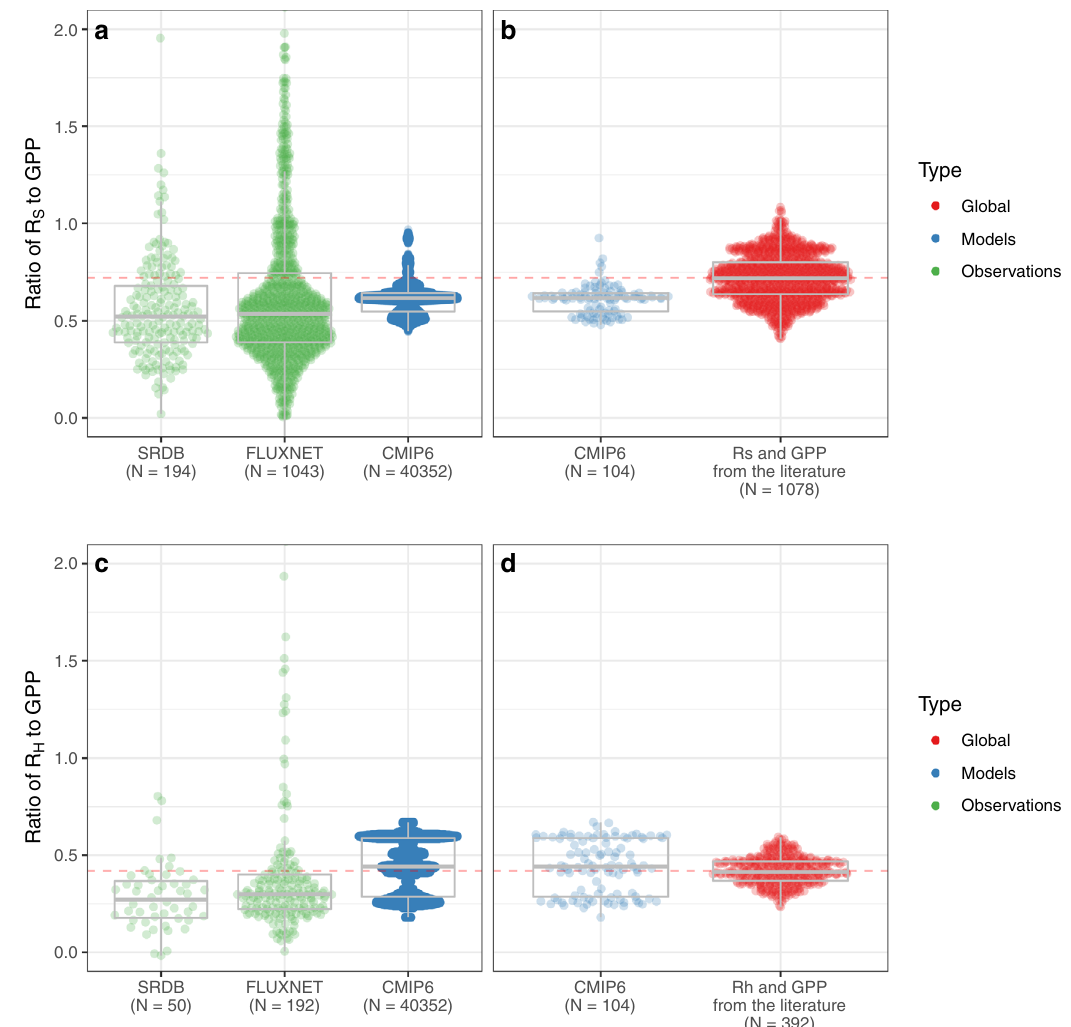
Fig. 2 Observations, estimates, and model results of the ratio of soil respiration (R S ) or heterotrophic respiration (R H ) to gross primary productivity (GPP), at different spatial scales and from different sources. a Observations, estimates, and model results of the ratio of R S to GPP at grid cell site-level; b Observations, estimates, and model results of the ratio of R S to GPP at a global scale; c Observations, estimates, and model results of the ratio of R H to GPP at grid cell site-level; d Observations, estimates, and model results of the ratio of R H to GPP at a global scale. Observational site-level data are from the global Soil Respiration Database (SRDB) and FLUXNET data (see Methods). The ratio of global R S and R H to global GPP is shown in red (and emphasized by the horizontal dashed lines), while results from the Coupled Model Intercomparison Project Phase 6 (CMIP6) at both the local grid cell site-level (values were extracted at coordinates corresponding to speci fi c SRBD and FLUXNET sites) and global scale are shown in blue. Note that the odd distribution of the former results from the diversity of model ensemble realization used. Each point grouping is arranged distributionally, with overlaid box-and-whisker plots summarizing the mean, 25 and 75% quantiles, and extreme values. There are 16 models from CMIP6 with R H data; R S from CMIP6 models was calculated based on R H and R root :R S ratio using a bootstrap